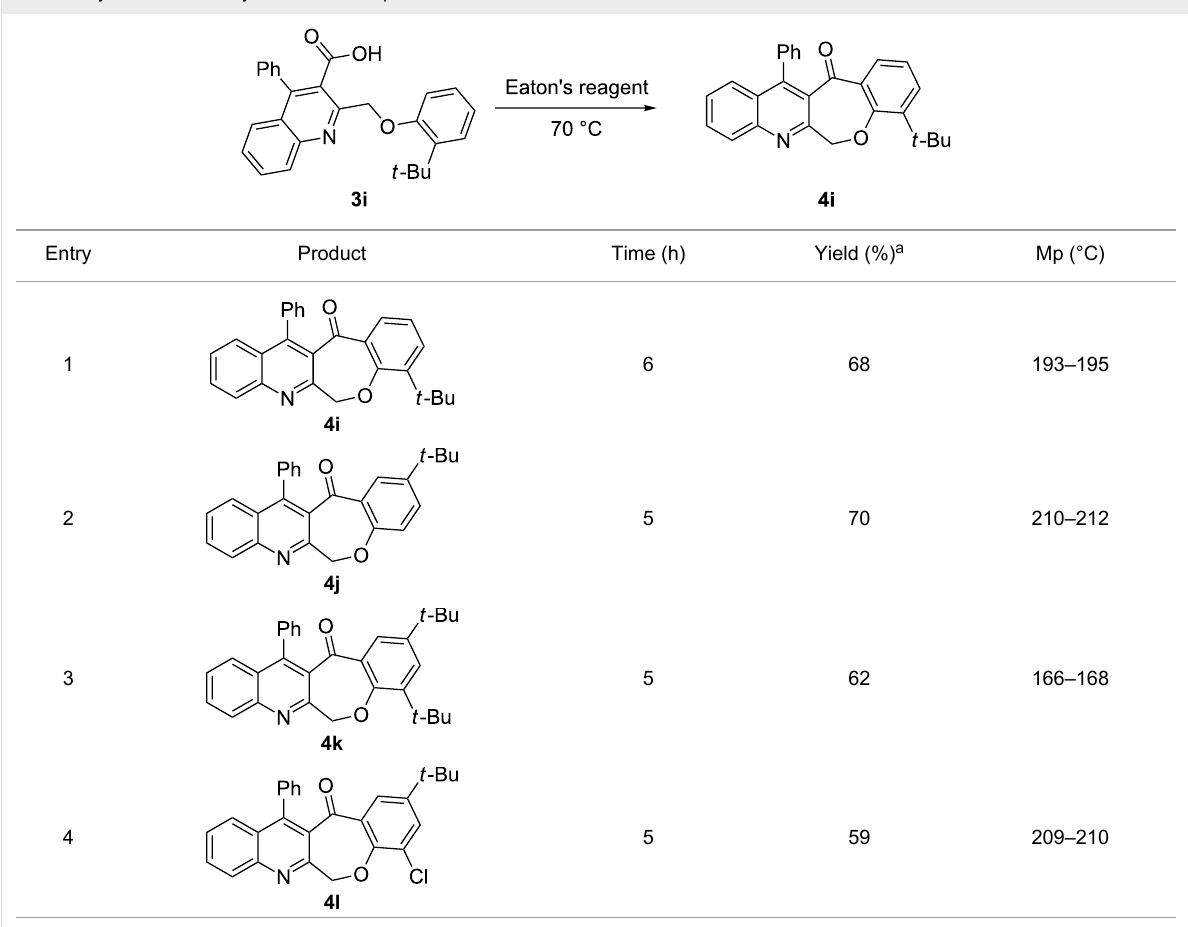
Table 3: Synthesis of tert -butyl-substituted compounds 4i – l